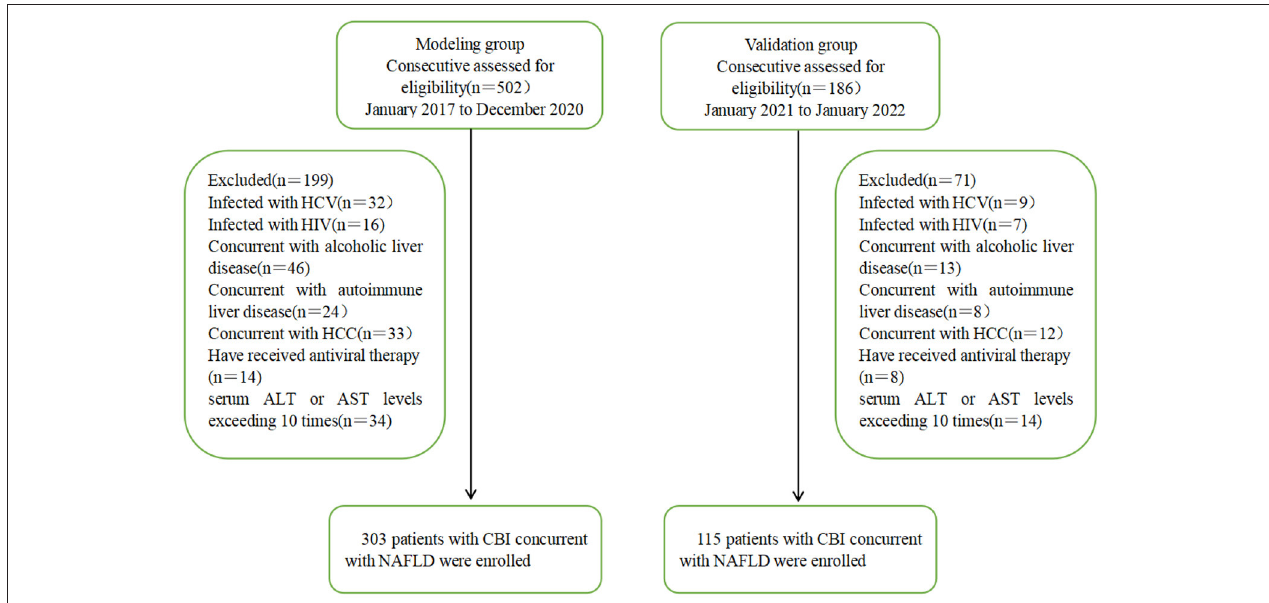
FIGURE 1 | Flowchart of patient recruitment in the modeling and validation groups. HCV, hepatitis C virus; HIV, Human Immunodeficiency Virus; HCC, Hepatocellular Carcinoma; ALT, alanine aminotransferase; AST, aspartate aminotransferase; CBI, chronic HBV infection; NAFLD, nonalcoholic fatty liver disease.